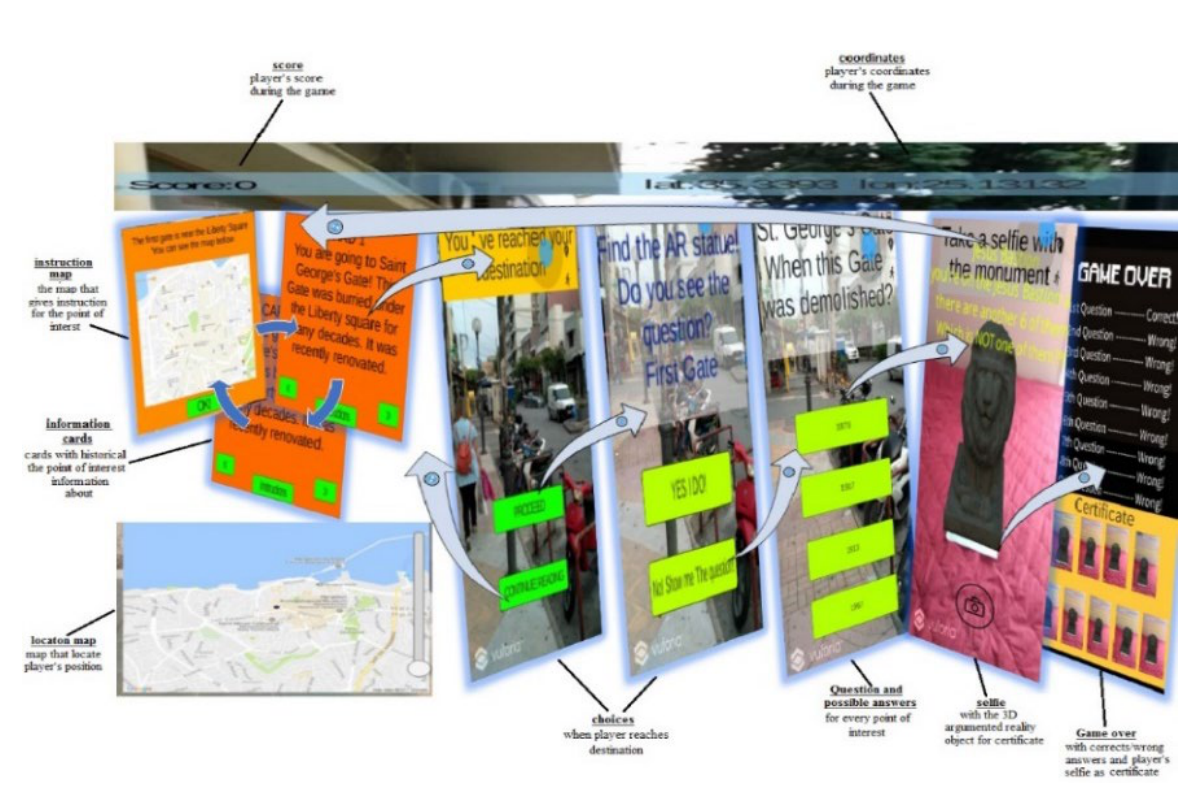
Figure 1. Game Graphical Presentation &